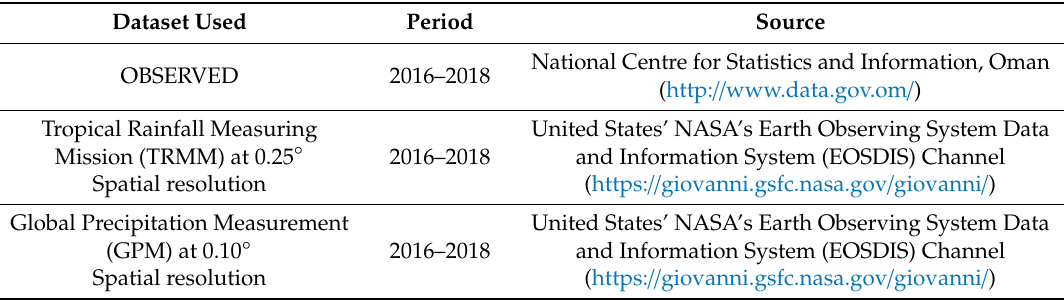
Table 1. Precipitation data sources, spatial and temporal resolutions used for evaluation.